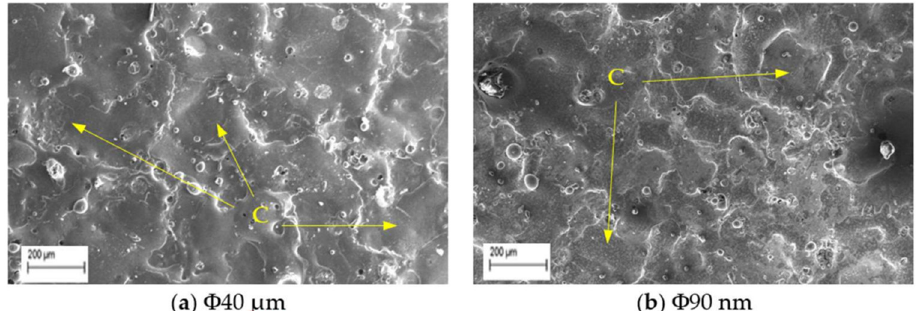
Figure 13. SEM micrograph of surface machined using T d = 300 µ s, I p = 6 A, V g = 100 V (C-crater).